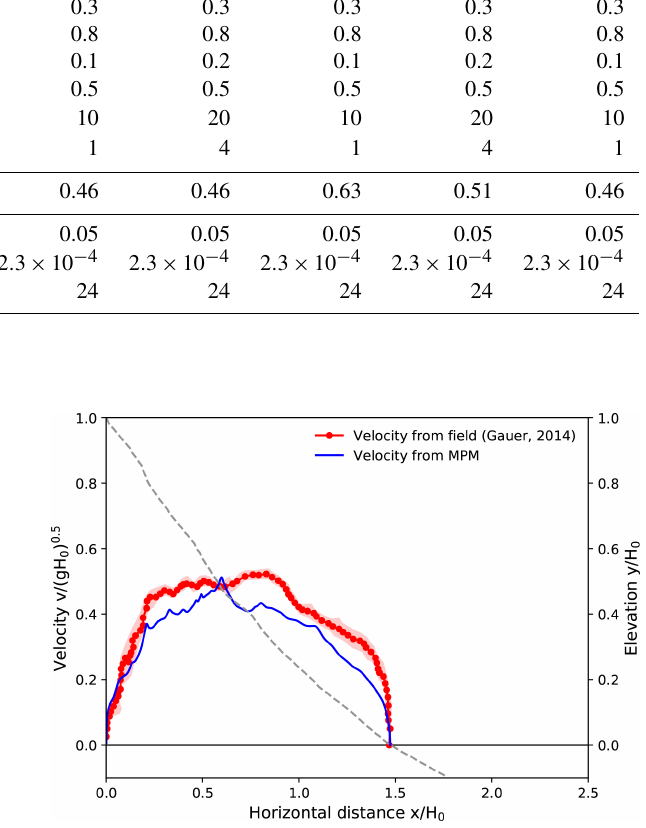
Figure 13. Front velocity distribution along the flow path for Case III: Himmelegg, 14 February 1990 (Arlberg, Austria). Drop height H 0 =